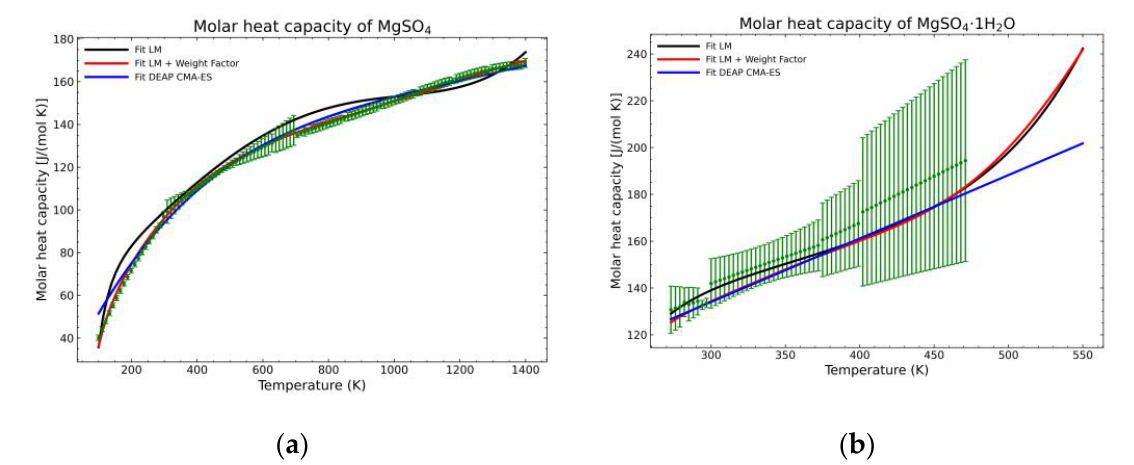
Figure 12. Comparison of the different fit results, showing the literature data in green (mean of the values) with the 95% confidence interval boundaries of: ( a ) MgSO 4 ; ( b ) MgSO 4 ·1H 2 O.